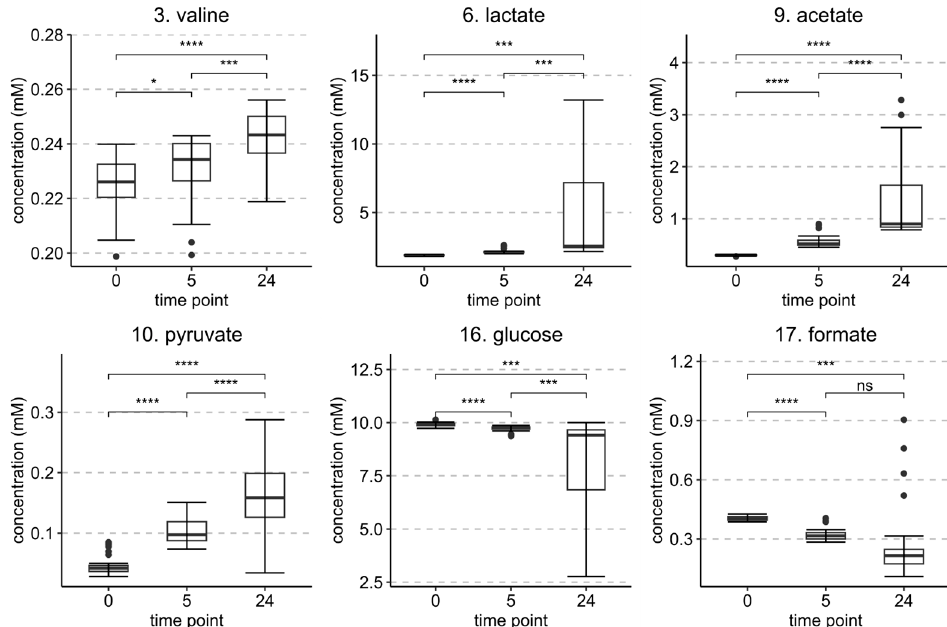
Figure 7. Statistically significant ( p < 0.05) identified metabolites and their concentrations from the S. aureus sample set at 0 h, 5 h, and 24 h time points. Metabolites are numbered according to Table 1. p values of difference are from a paired t-test (n = 30). Levels of significance: **** p < 0.0001; *** p < 0.001; * p < 0.05; ns = non-significant.